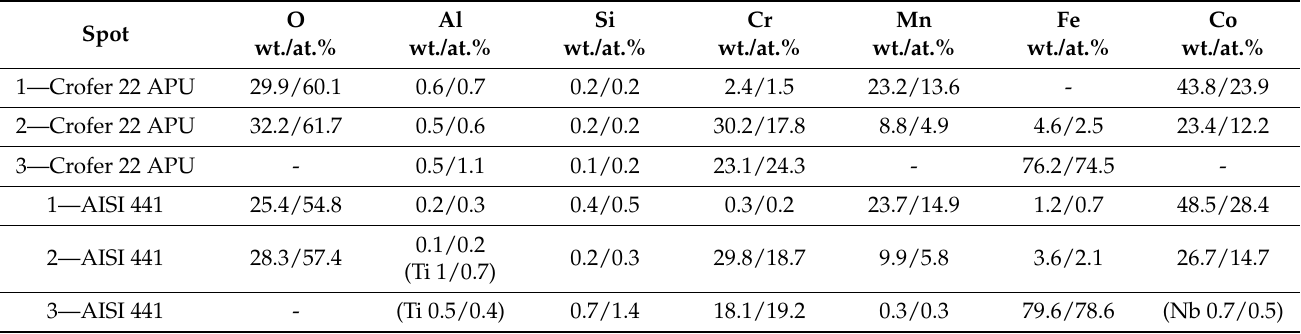
Figure 6. Uncoated Crofer 22 APU ( left ) and AISI 441 ( right ) after 1500 h at 800 °C in oxidizing atmosphere, showing 2500× ( upper ) and 10000× ( lower ) magnifications. Dashed black lines show approximately the interface between chromia and (Cr,Mn) 3 O 4 spinel oxides in the pictures at higher magnification. Table 4. Element concentrations in wt./at.% measured with EDS analysis of MCO coated Crofer 22 APU and AISI 441 after 1500 h at 700 ◦ C. The location of the analysis spots is marked in Figure 8. The presence of Al likely originates from the polishing